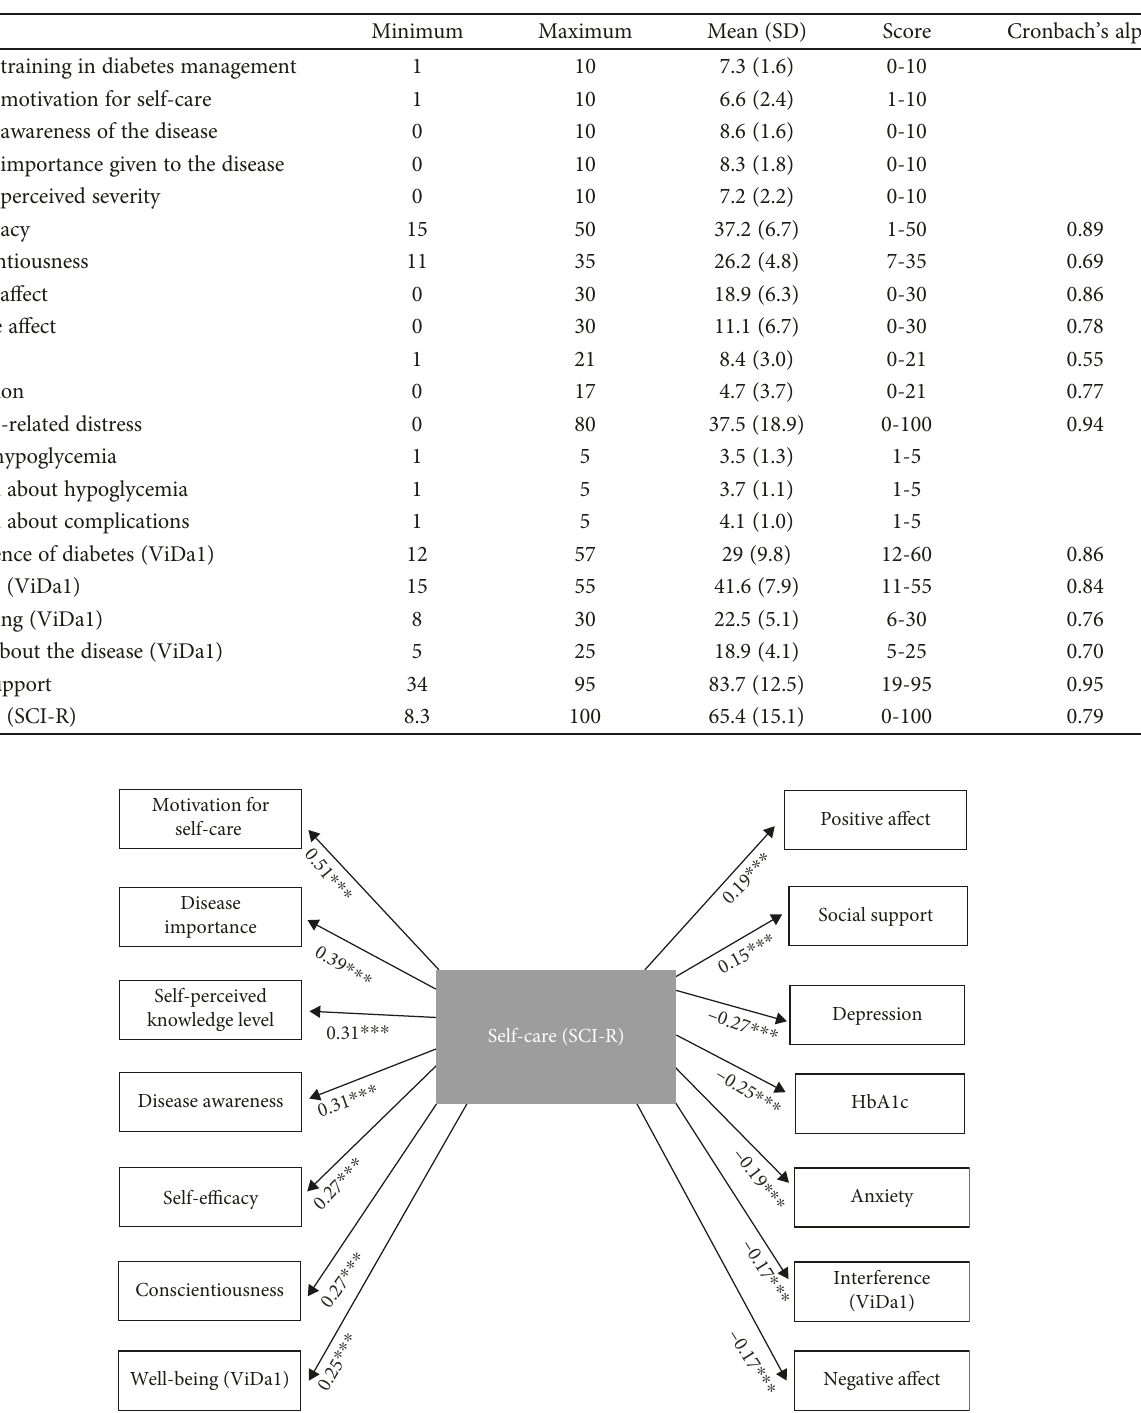
Table 2: Means (SD), minimum and maximum scores, scales, and Cronbach ’ s alpha for variables ( N = 428 ).